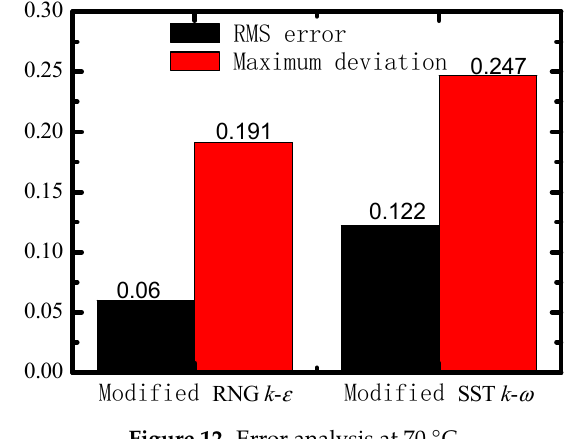
Figure 13. Vapor volume fraction distribution on the surface of the NACA0015 hydrofoil.